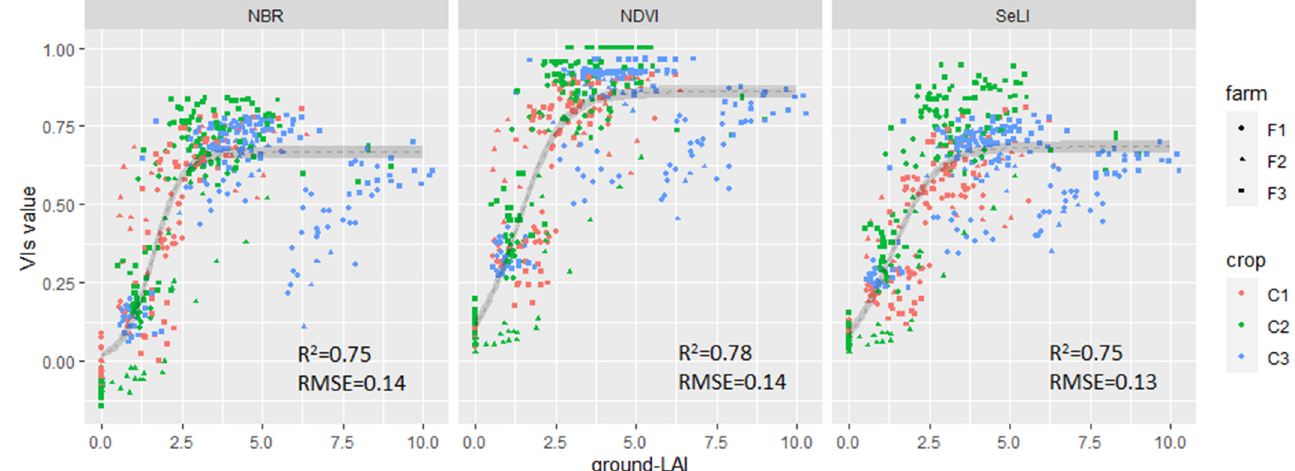
Figure A2. Non-linear regression between ground-LAI and VIs (NBR, NDVI, and SeLI), according to the three-parameter logistic function (L.3). Dashed line corresponds to the regression curve, while colored dots are the three crops: Yellow for winter wheat (C1), blue for maize (C2), and orange for alfalfa (C3). The shapes represent the farms (F1, F2 and F3).